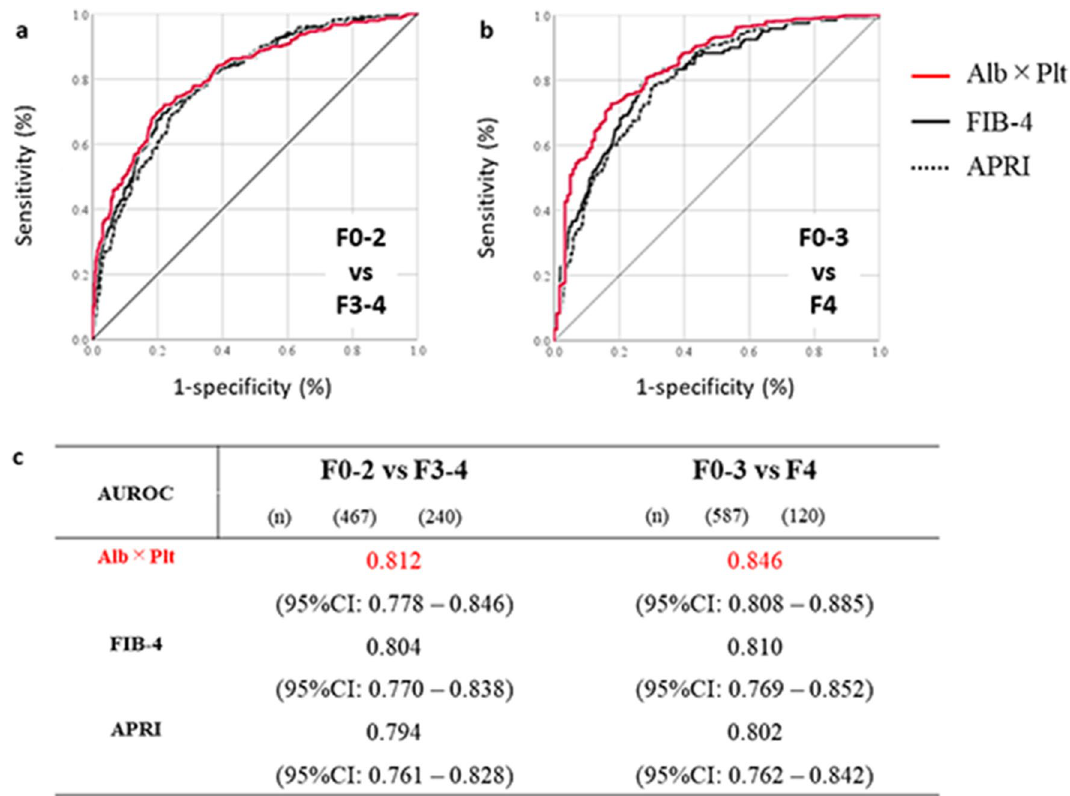
Figure 5. Differential diagnosis of liver fibrosis by the Albumin platelet product in a validation cohort . ROC analysis was performed to evaluate diagnostic abilities of Albumin platelet product for advanced liver fibrosis (F3–4) from nonadvanced fibrosis (F0–2) ( a ); for cirrhosis from noncirrhotic status (F0–3) ( b ). Albumin bilirubin product yielded the largest area under curve among three indices; Albumin bilirubin product, Fibrosis-4 index and APRI ( c